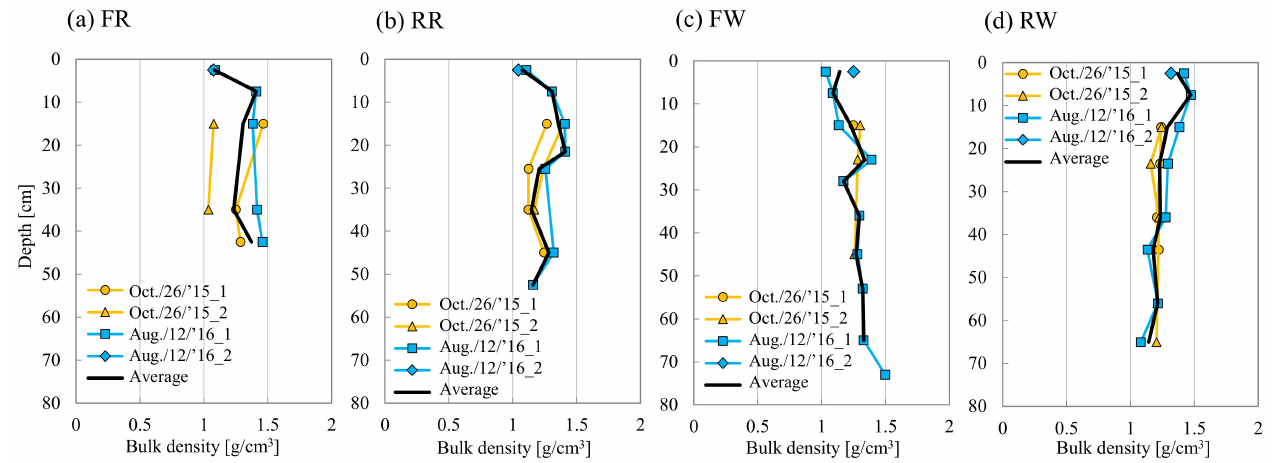
Figure 8. Vertical distributions of bulk density at ( a ) FR, ( b ) RR, ( c ) FW, and ( d )